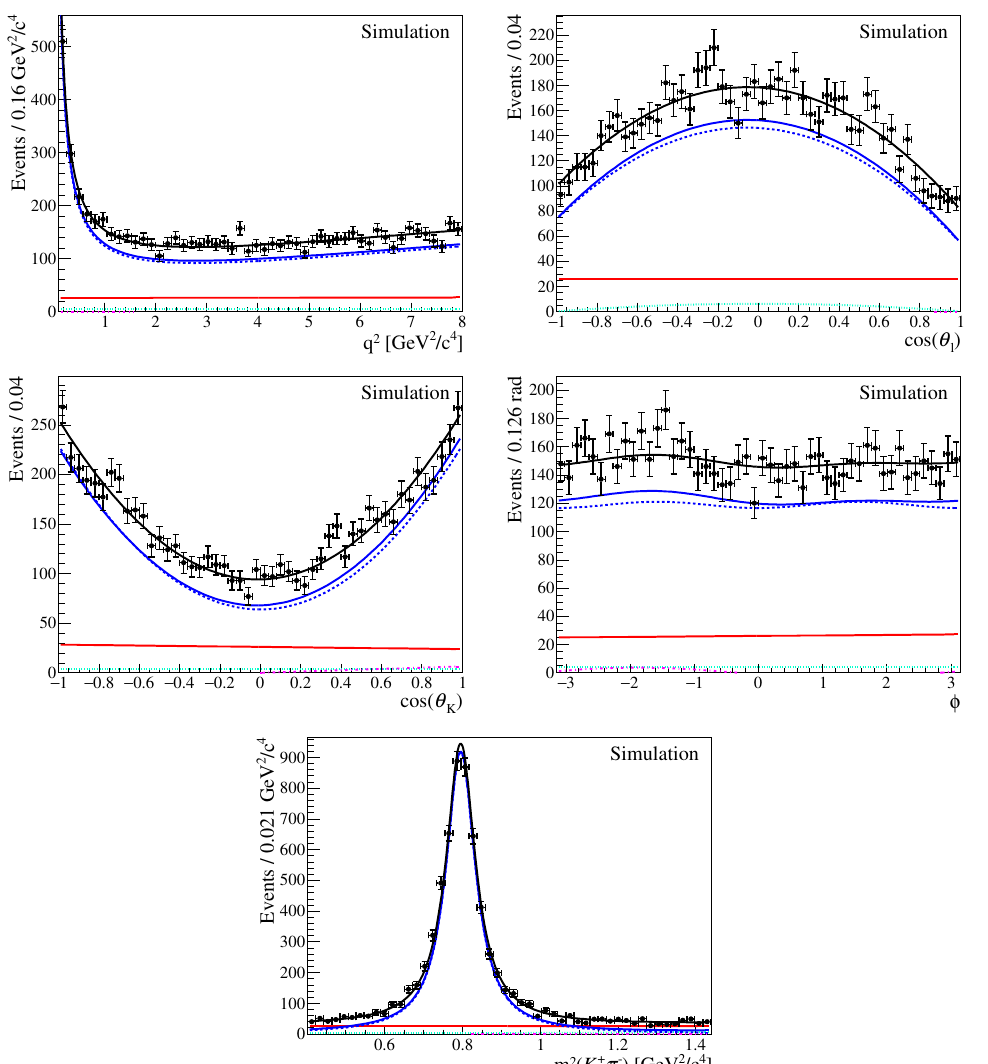
Figure 7. Results from the (cid:12)t of a single pseudoexperiment varying the Wilson coe(cid:14)cients Re( C 9 ) and Re( C 10 ). Simulated events are overlaid with projections of the (cid:12)tted PDF on q 2 , the three decay angles cos (cid:18) l , cos (cid:18) K and (cid:30) and m 2 in the q 2 range 0 : 1 < q 2 < 8 : 0 GeV 2 =c 4 . The simu- K(cid:25) lated events and projections are shown for the signal region (cid:6) 50 MeV =c 2 around the B 0 mass to enhance the signal fraction. The black solid line denotes the full PDF, the blue solid line the sig- nal component. The blue dashed line gives the P-wave and the teal dotted line the S-wave part. The magenta dash-dotted line (cid:12)nally gives the P-wave/S-wave interference and the red line the background contribution.